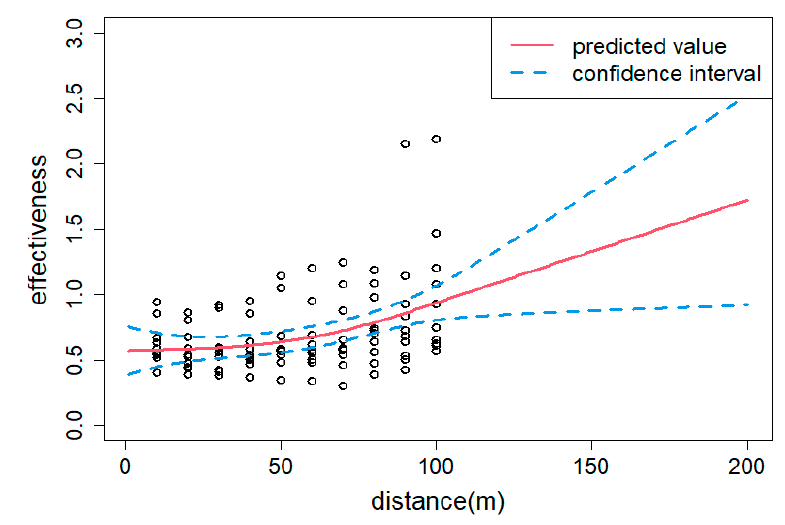
Figure 7. Scatterplot and fitted line plot with confidence intervals.